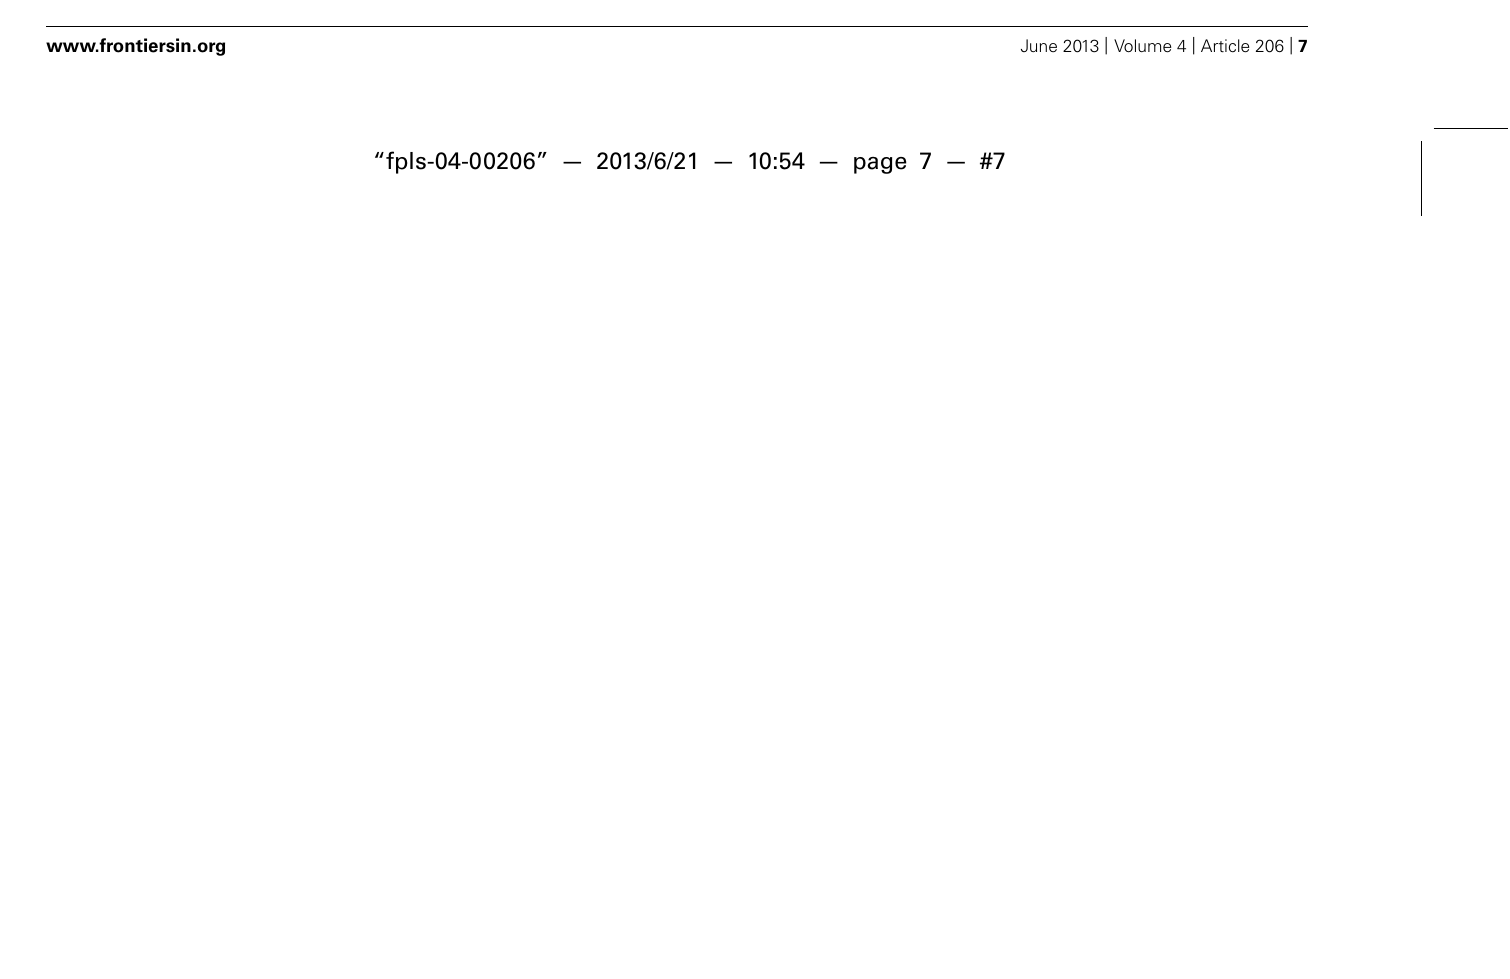
to the SlEF gene expression in the same samples. Data show the relative expression level ( ± SE). For each tomato genotype asterisks indicate statistically significant differences between Trichoderma induced and non-induced plants (Student’s t -test, P < 0.05, n =